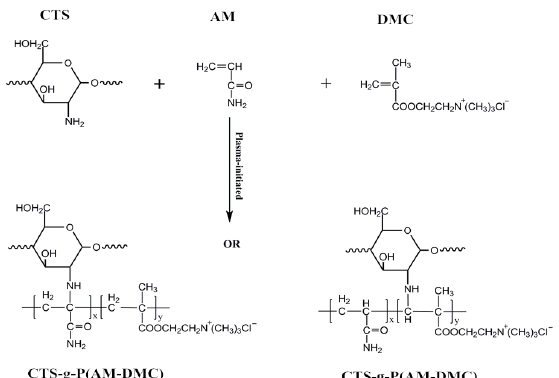
Scheme 1. The synthesis of chitosan- graft -poly(acrylamide-and methacryloyl ethyl trimethyl